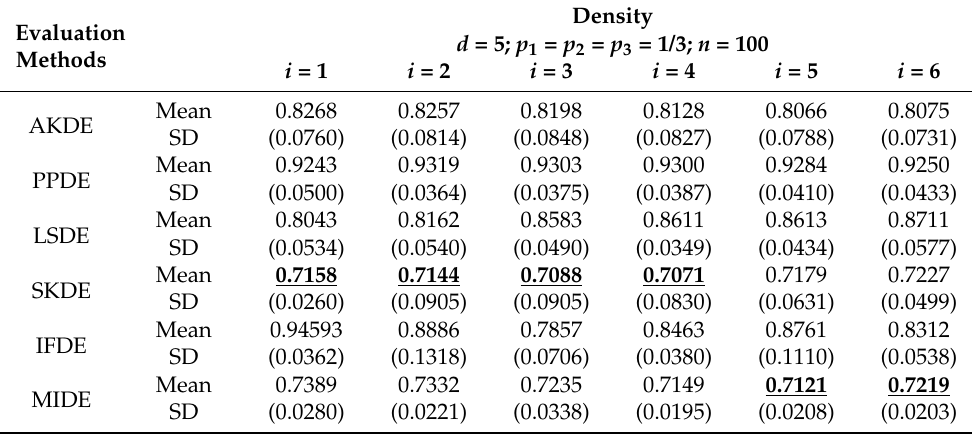
Table 2. An example of mean absolute percentage